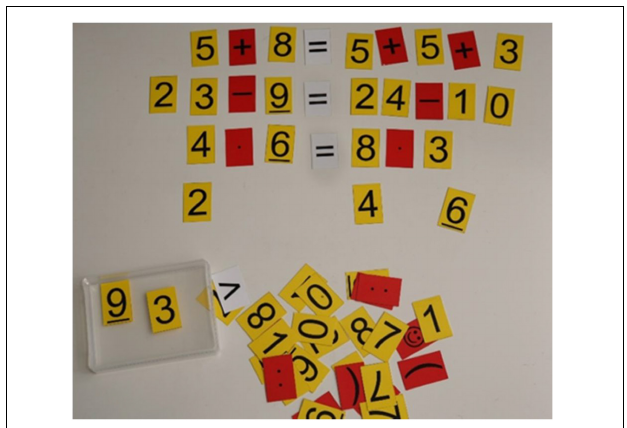
FIGURE 4 | Combining equations by moving cards representing numbers and equalities.